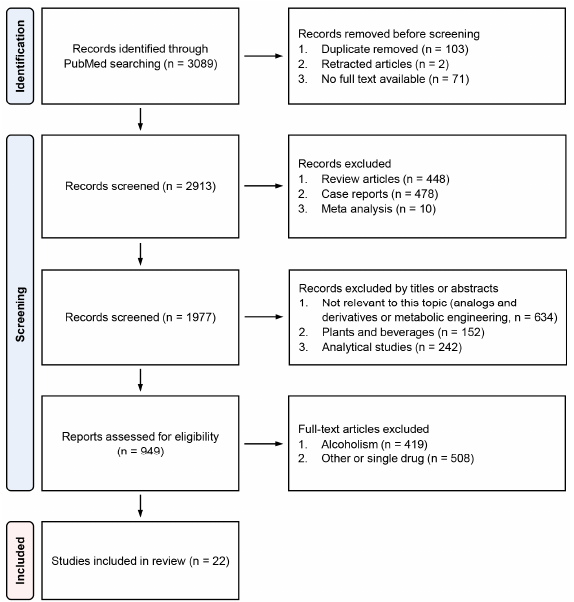
Figure 1. Flow diagram of paper selection steps.